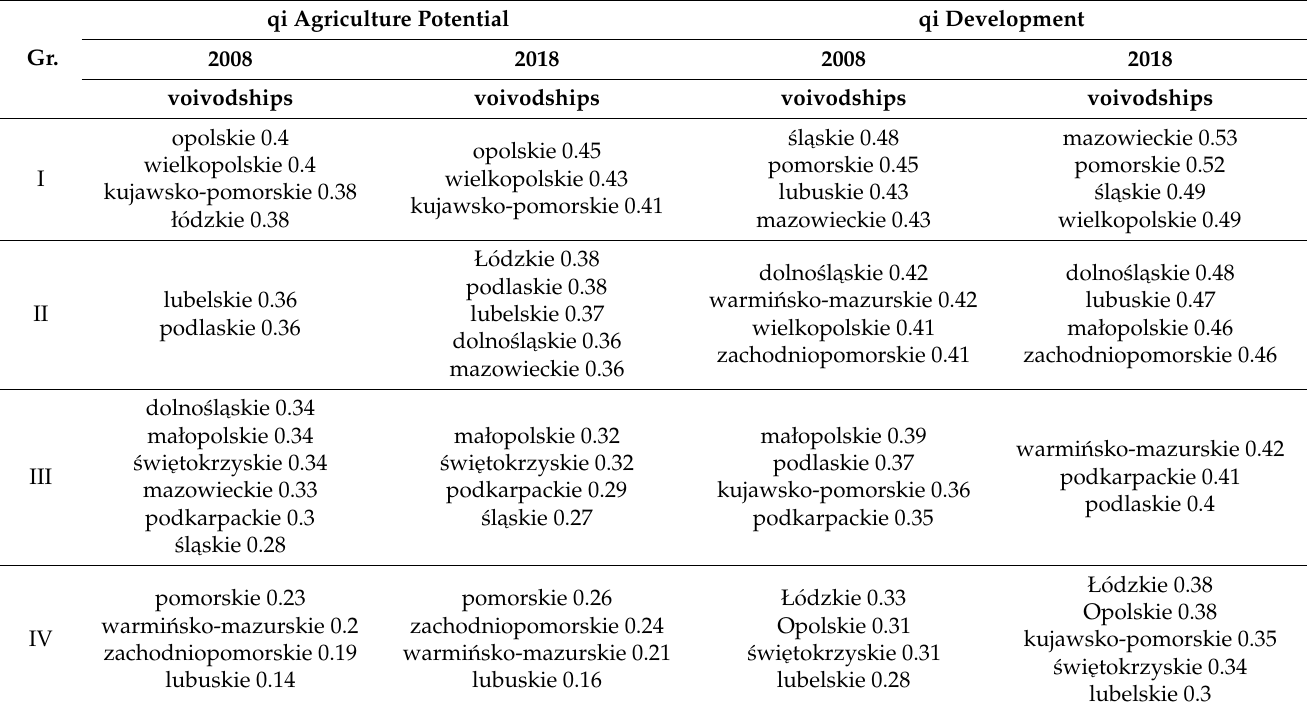
Table 3. Classification of voivodships in Poland according to the value of the synthetic measure of agricultural development and potential (in 2008, 2018).